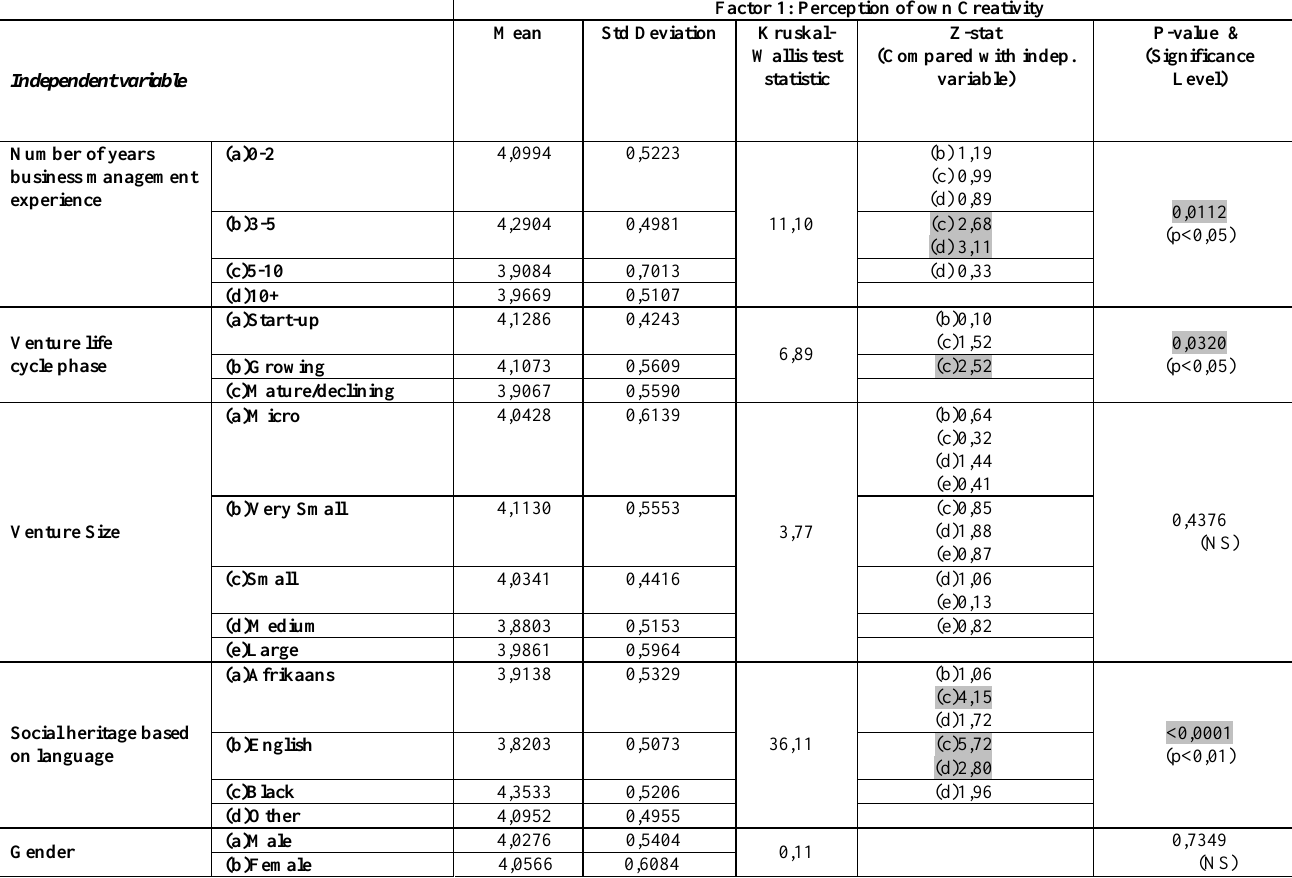
Factor 1: Perception of own Creativity